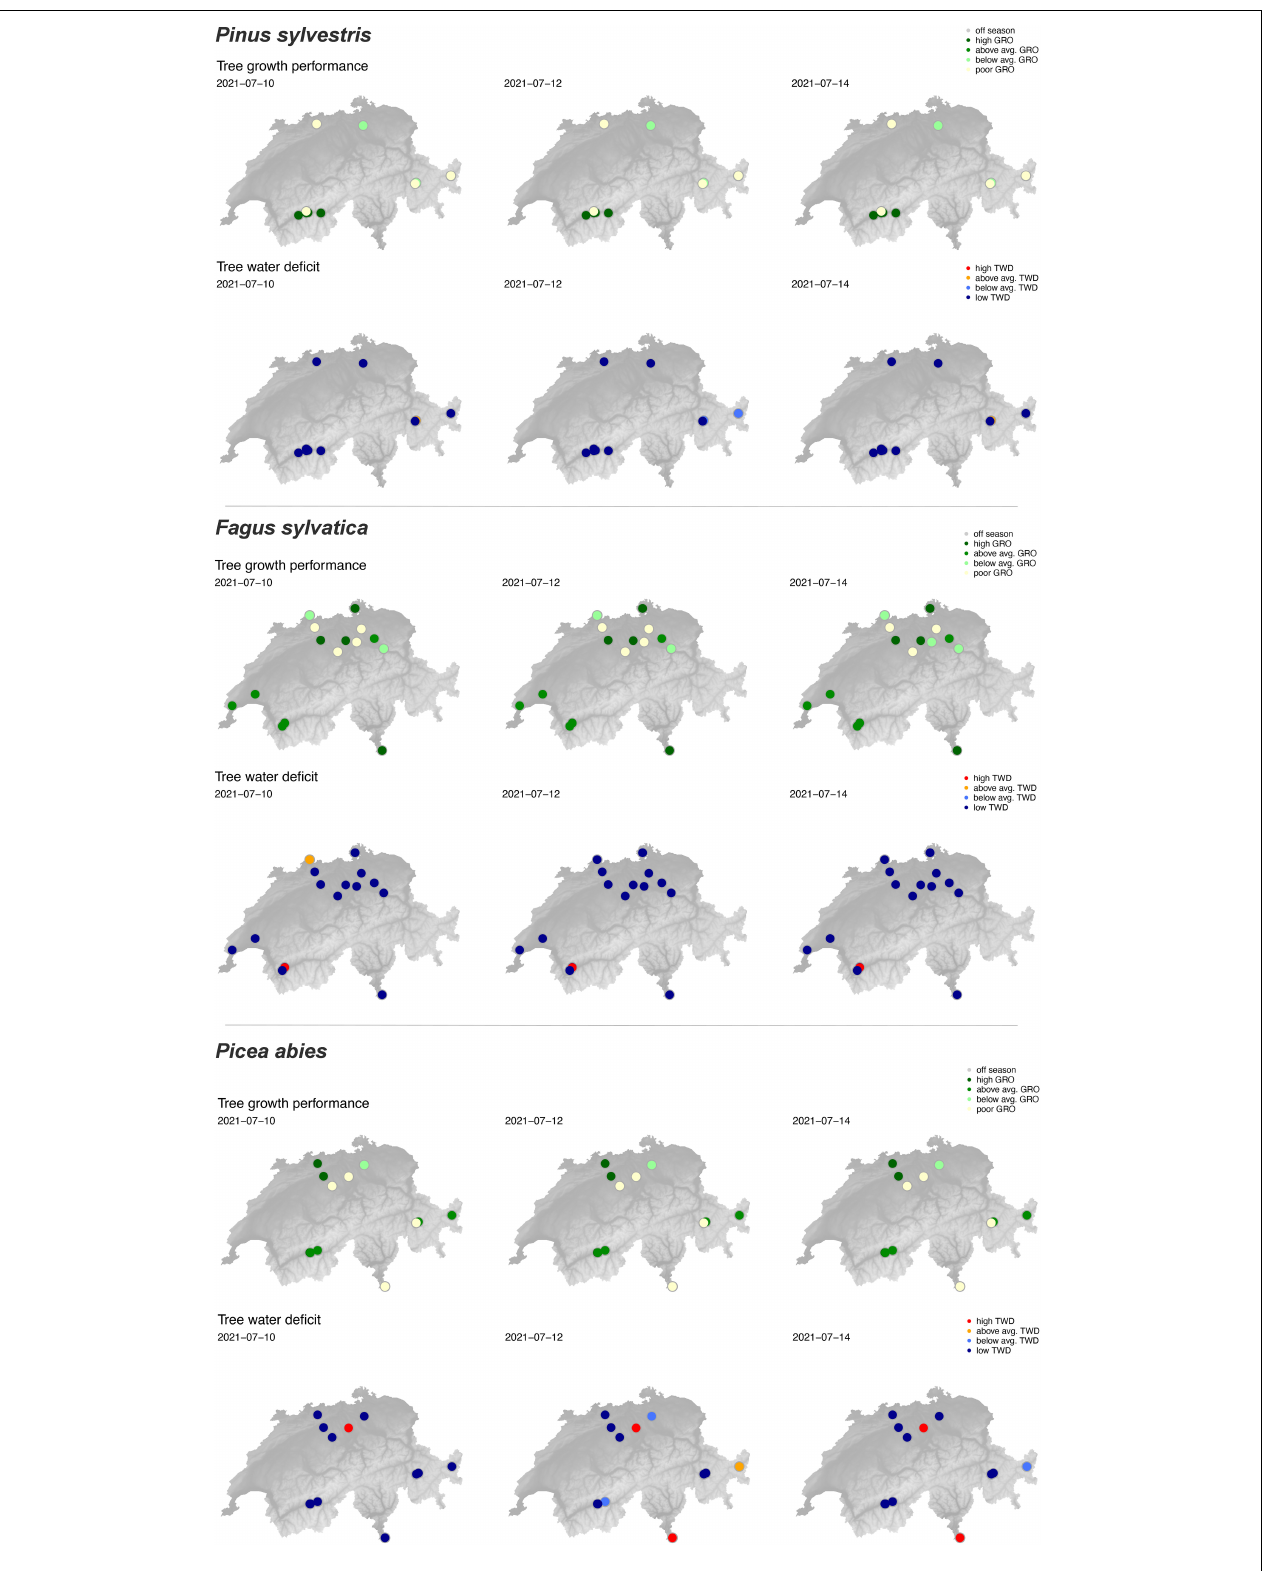
FIGURE 7 | Examples of species-specific stem growth (GRO) and tree water deficit (TWD) status at the available TreeNet sites on 10, 12, and 14 July 2021. Upper maps show the color-coded growth performance, the lower maps the same for TWD.